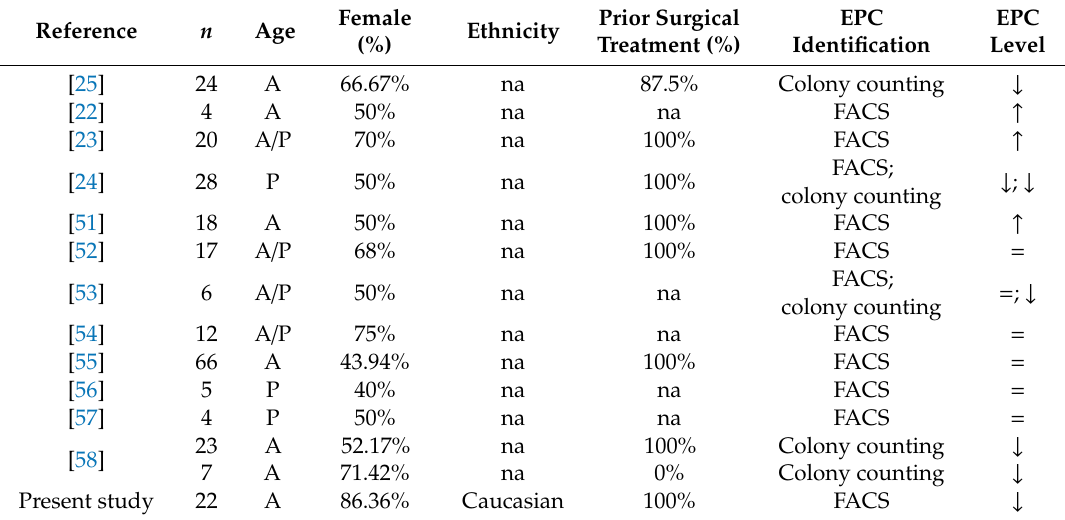
Table 4. Summary of studies about EPC level in MA: Number ( n ), age (A, adult; P, pediatric), percentage of female, ethnicity, percentage of non-operated MA patients, methods for EPC identification / quantification (FACS, Fluorescence-activated cell sorting), and EPC amount variation in MA patients as compared to HD are reported ( ↑ , EPC increased level; ↓ , EPC decreased level; = , EPC una ff ected level; na, not